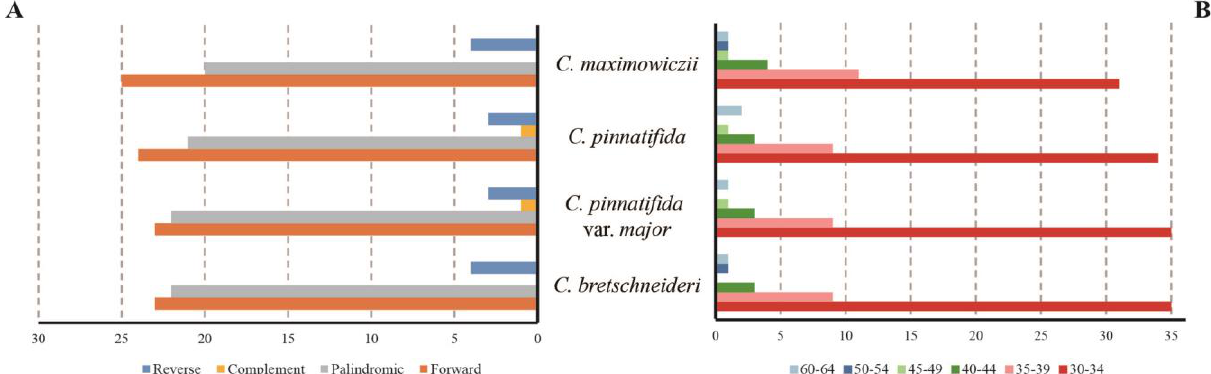
Figure 6. Analysis of repeat sequences in the four Crataegus plastomes. ( A ) Numbers of different types of repeat sequences. ( B ) Length distribution of repeat sequences in their respective plastomes.